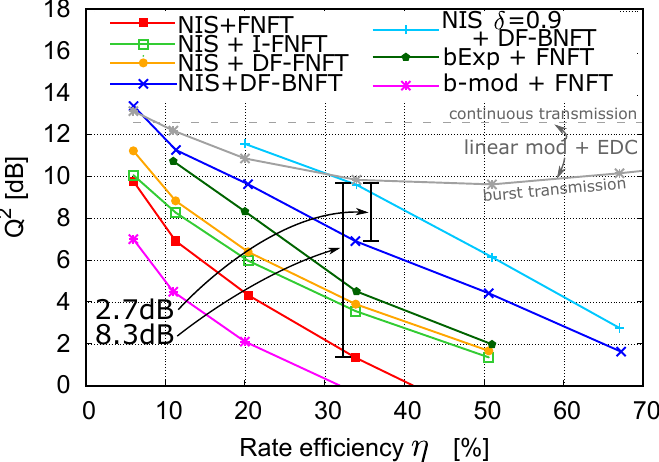
Figure 8. Peak performance of NFDM systems with different modulation and detection strategies, compared to a linearly modulated system with burst (solid) or continuous (dashed)